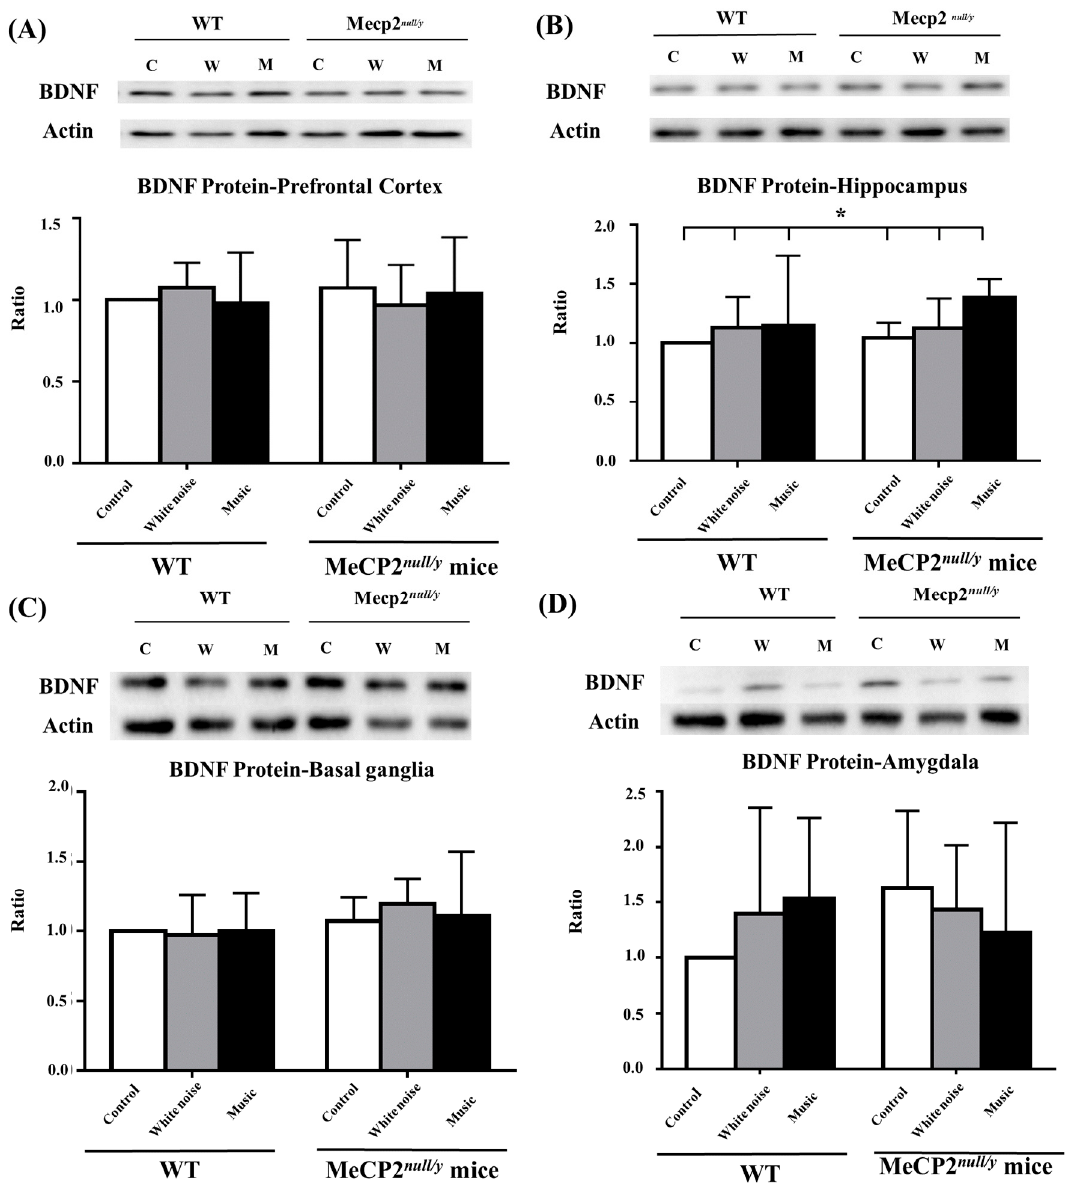
Figure 3. Comparison of the BDNF protein level in wild-type mice and mecp2 null/y mice in different brain regions. ( A ) Prefrontal cortex, ( B ) hippocampus, ( C ) basal ganglia, ( D ) amygdala (* p < 0.05).